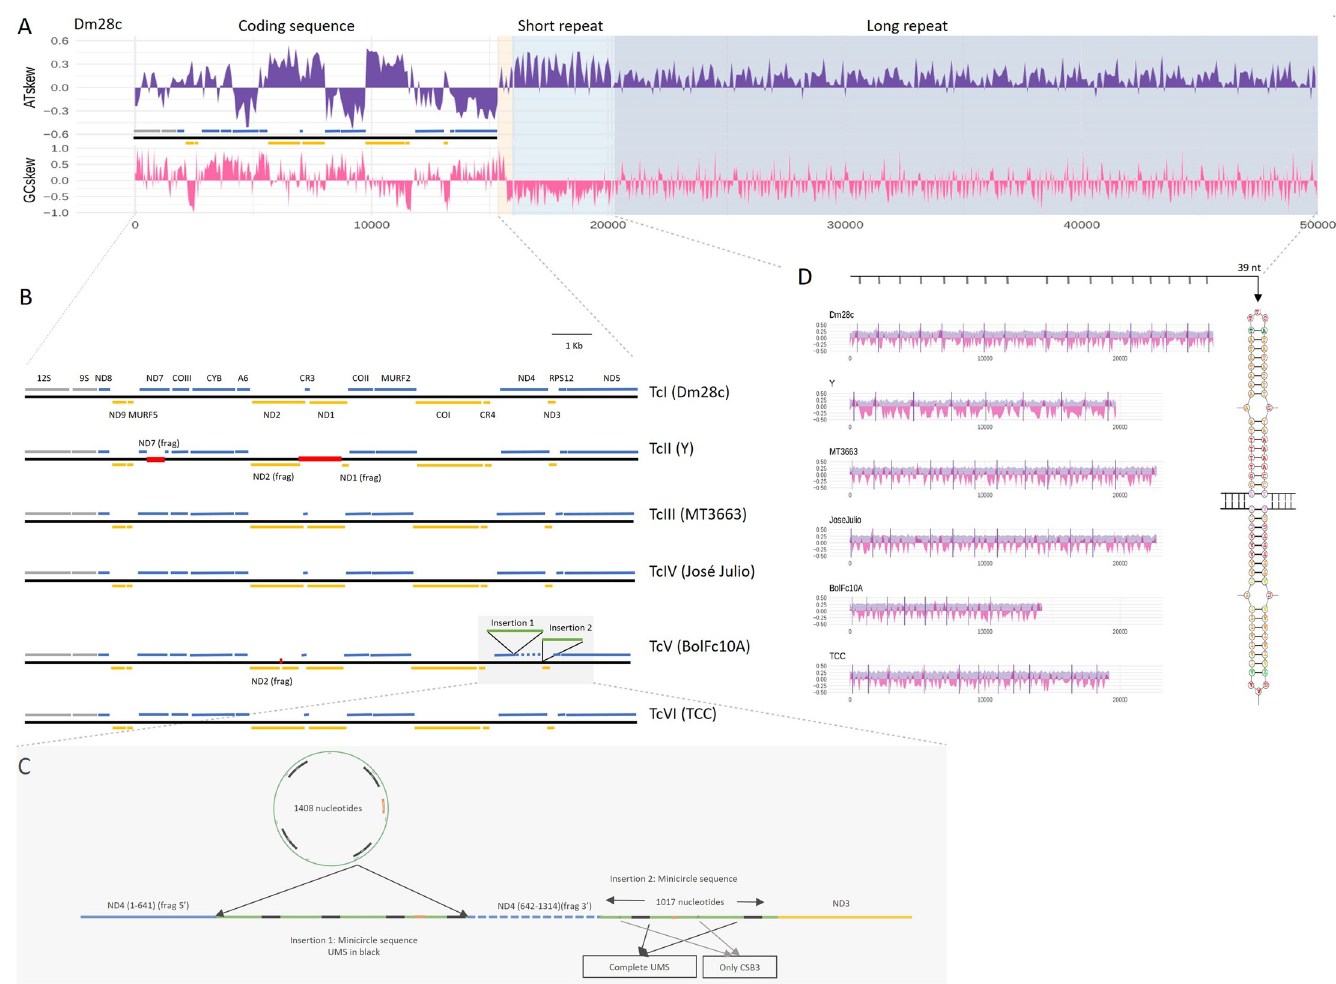
Fig 2. Structure conservation among T . cruzi maxicircles. A. Schematic representation of Tc Dm28c maxicircle including: coding region, AT-rich, short repeat region and long repeat region. AT-skew and GC-skew are represented in violet and pink respectively. B. Representation of coding region from the six DTU assemblies. Genes are indicated in blue (positive strand), orange (negative strand) or gray (ribosomal genes). Deletions are indicated with red lines, and insertions with green lines. C. Zoom of insertion in TcBolFc10A (see text). D. Conservation of structure of long repeat regions among DTU’s showing the 39 bp palindromic